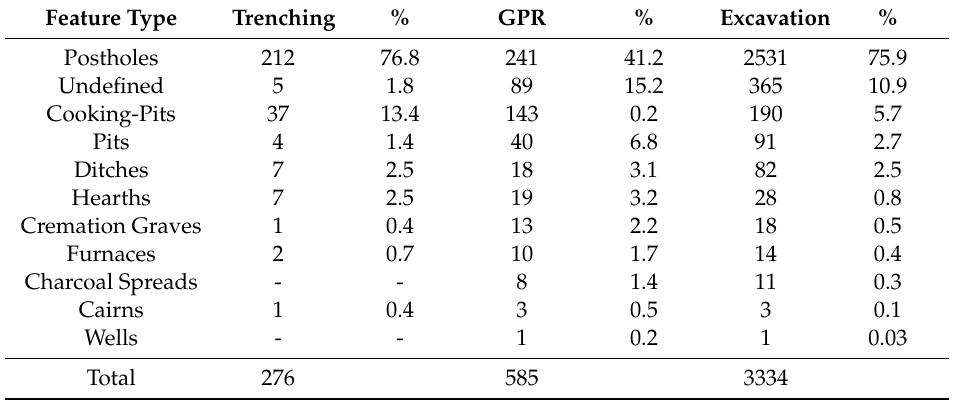
Table 3. Features identified through trial trenching, detected by GPR and finally excavated at